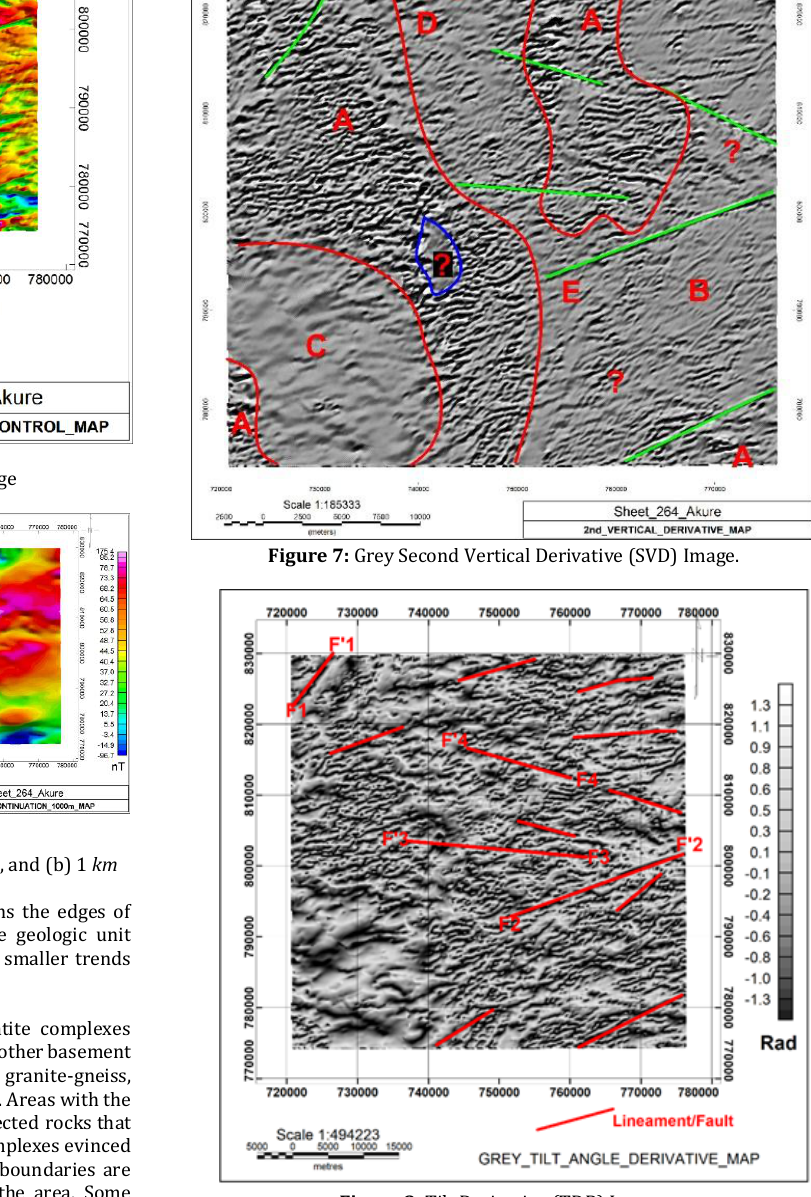
Figure 8: Tilt Derivative (TDR)